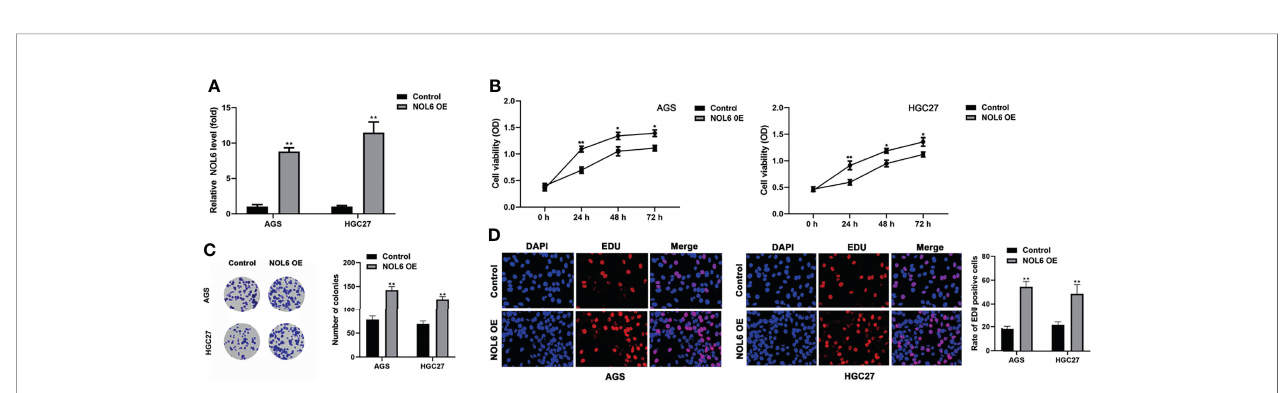
FIGURE 2 | Over-expression of NOL6 increased proliferation and colony formation of AGS and HGC cells. (A) Effect of NOL6 OE on the gene expression of NOL6 in the AGS and HGC cells. (B) Effect of NOL6 OE on the viability of the AGS and HGC cells was evaluated by MTT assay. (C) Effect of NOL6 OE on the number of colonies in the AGS and HGC cells was detected by colony formation assay. (D) Effect of NOL6 OE on the proliferation of the AGS and HGC cells was assessed by EDU staining. (*p < 0.05, **p < 0.01, v.s.si-nc).